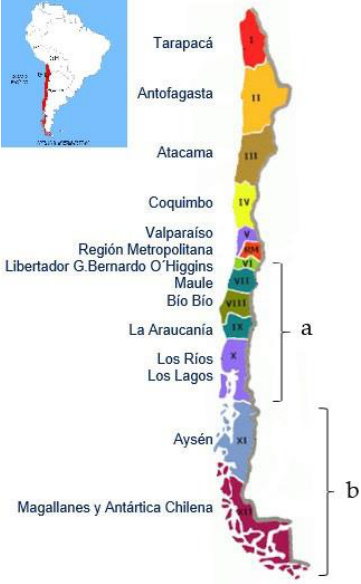
Figure 8. Map of Chile showing the central-southern region ( a ) and the Chilean Patagonia ( b ).